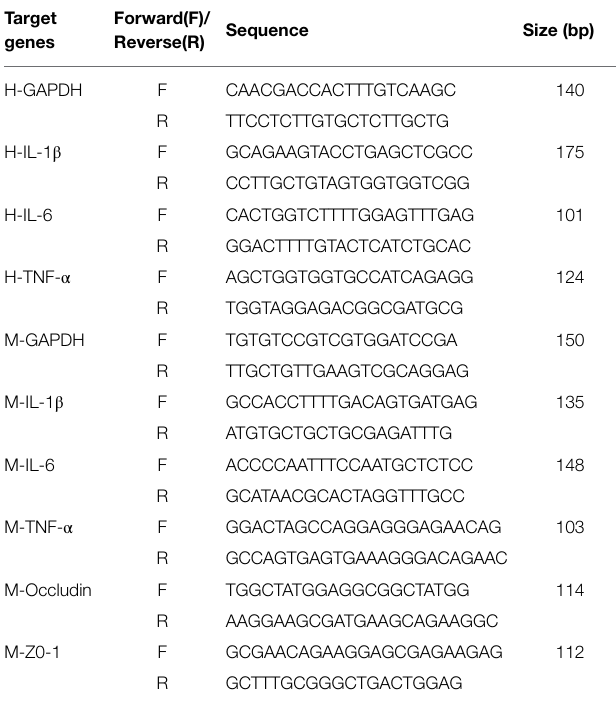
TABLE 1 | Primer sequences used for real-time RT-PCR. Target